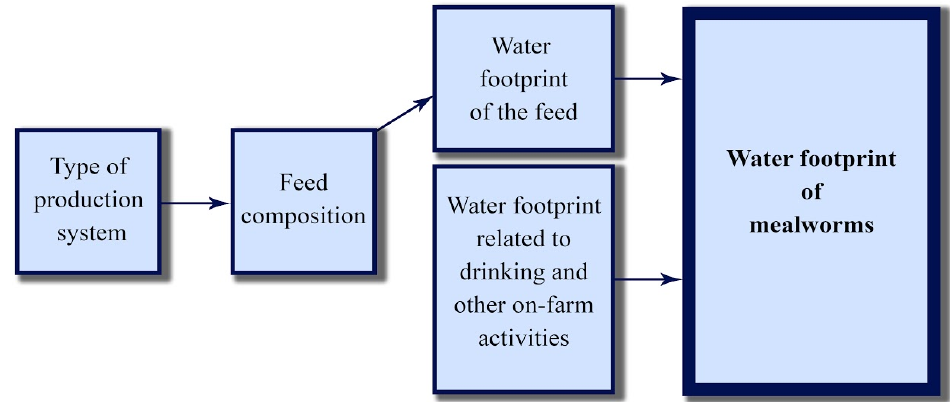
Figure 1. Factors determining the water footprint of farmed